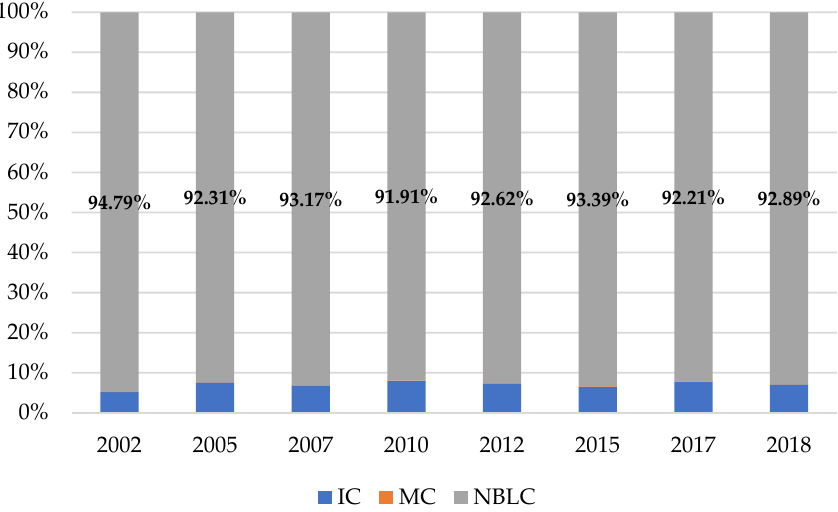
Figure 2. VICE composition of the construction sector in eight different years. Note: the VICE stands for total energy consumption to satisfy the final